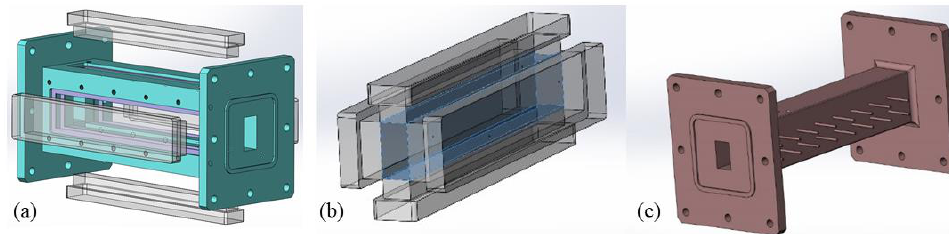
Figure 5. Test section ( a ) steel frame and quartz glasses of the optical test section, ( b ) the flow path combined with the four glasses, ( c ) test section for pressure measurement.